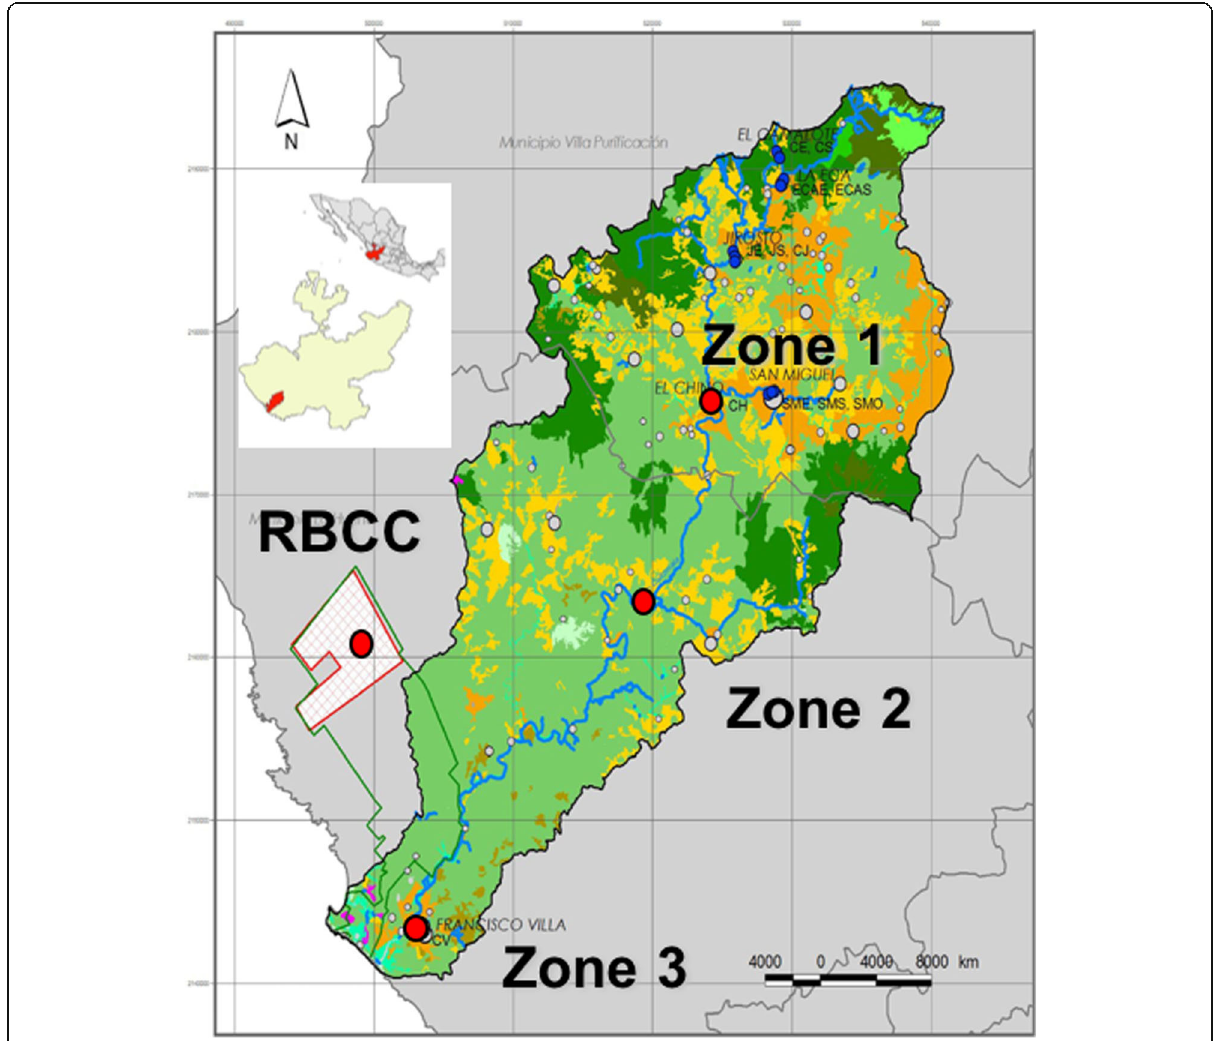
Fig. 1 Map of study sites (red dots) in the Cuitzmala River Basin, Jalisco,